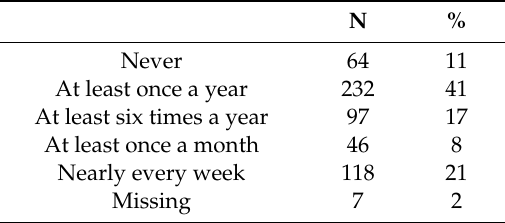
Table 10. Public worship